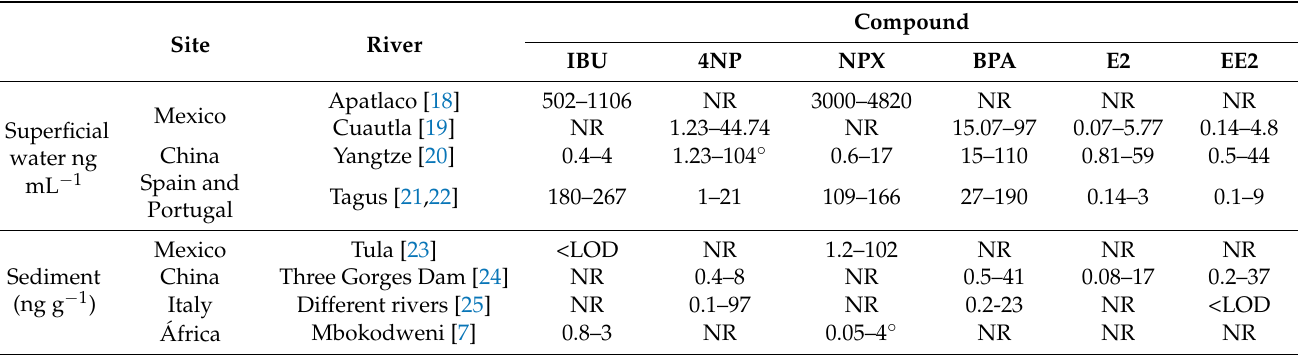
Table 5. Comparison of the concentration of drugs and CDEs found in the Apatlaco river basin and other